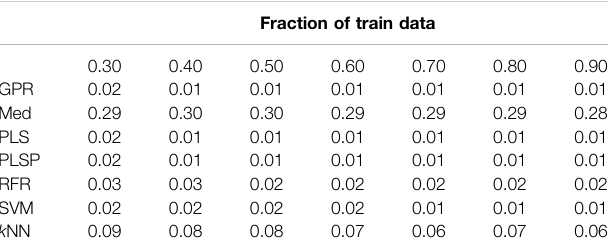
TABLE 2 | Prediction of molecular weight, random shuf fl ing, skeleton spheres descriptor. The fi rst column indicates the machine learning algorithm. The fi rst row is the fraction of data used for model construction. The other values are the relative errors of the test data.